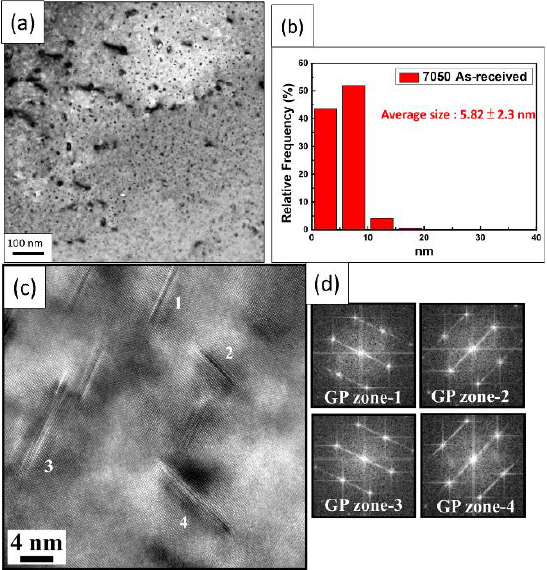
Figure 5. ( a ) TEM micrograph presenting 𝜂′ and 𝜂 precipitates dispersed throughout the alumi- num matrix. ( b ) Measured precipitate size and distribution. ( c ) High-resolution TEM (HRTEM) characterizing multi-atomic layers of GP zones. ( d ) The respective diffractograms by fast Fourier transform